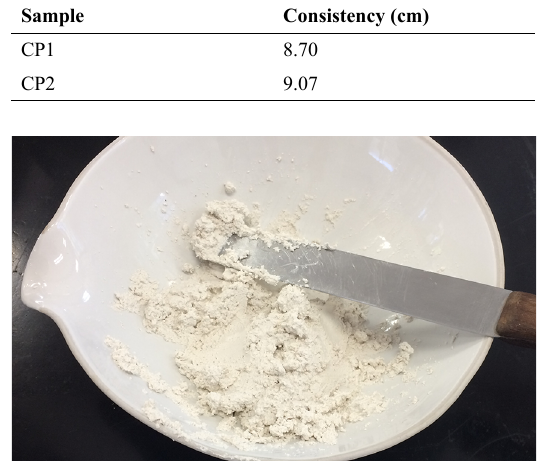
Table 6. Mini-slump consistency results of commercial samples.